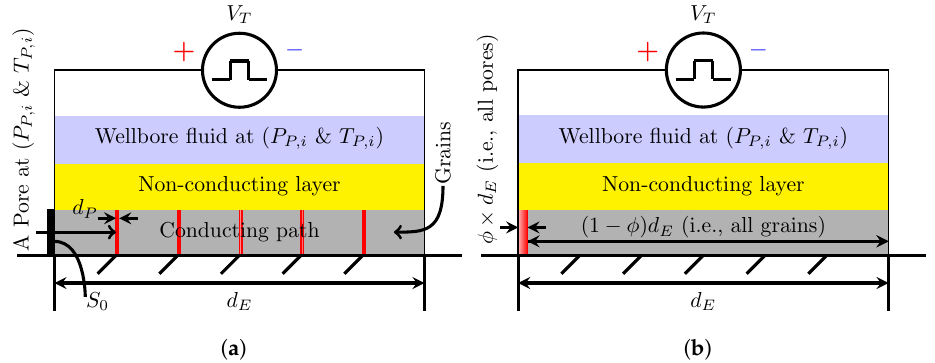
Figure 1. ( a ) Schematic of the one-dimensional configuration used for the simulation. The conducting path represents the path of current flow through the rock mass, where the damage occurs between the two electrodes. ( b ) The compact form of the same schematic, enabling utilization of the capacitance circuit model (Section